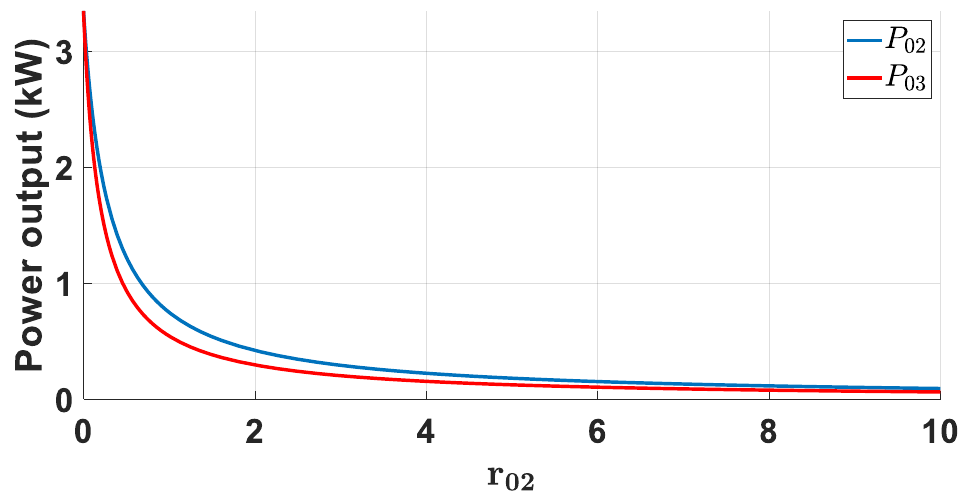
Figure 6. Sensitivity of 𝑃 02 and 𝑃 03 to 𝑟 02 .